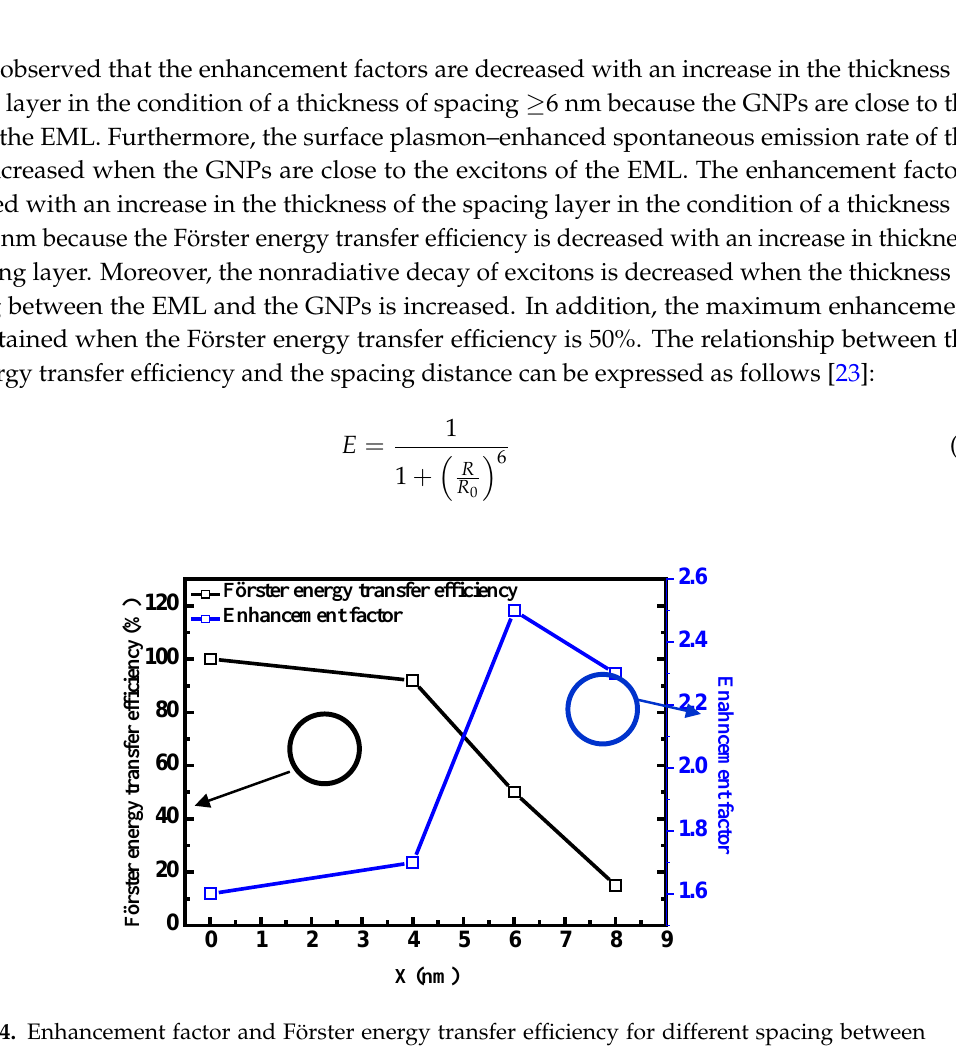
Figure 4. Enhancement factor and Förster energy transfer efficiency for different spacing between emission layer and GNPs.